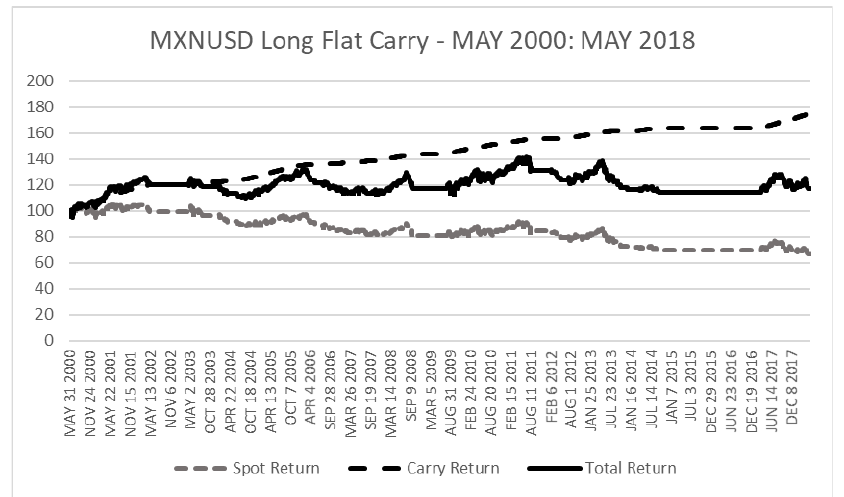
Figure 2. MXNUSD Long Flat Carry. Source: Authors elaboration from financial series extracted from